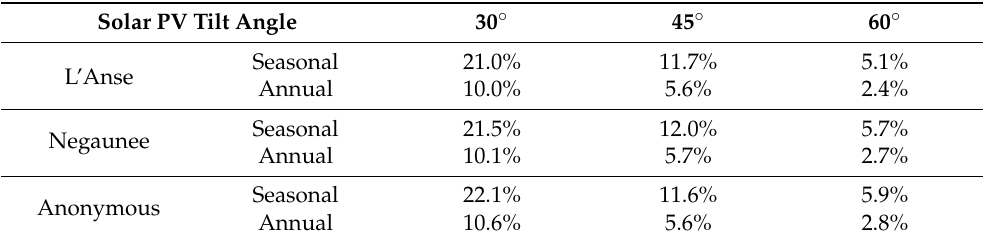
Table 2. The estimated seasonal and annual snow losses for each PV tilt angle in each case study com-